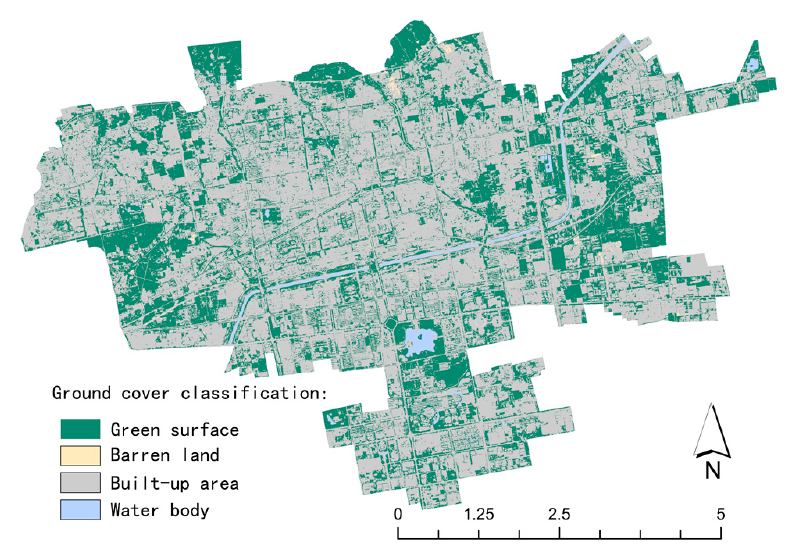
Figure 2. Ground cover classification.